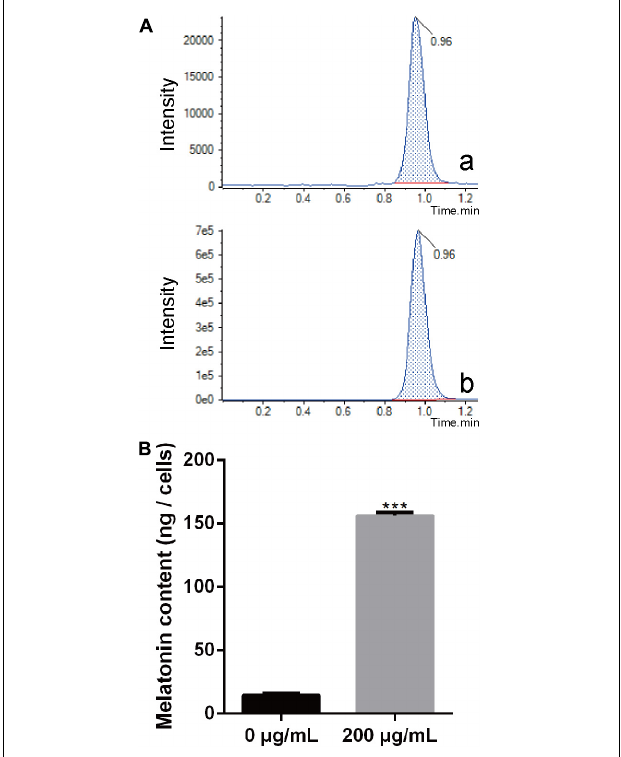
FIGURE 3 | Extraction and identification of melatonin in Xoo . (A) Chromatogram corresponding to melatonin. (a) Chromatogram corresponding to melatonin collected from PXO99 cells not treated with melatonin (Sigma). (b) Chromatogram corresponding to melatonin collected from PXO99 cells pre-treated with melatonin (Sigma). (B) Statistical analysis of melatonin (ng/cells) from PXO99 cells. UV response: 280 nm. ∗∗∗ P < 0.001.